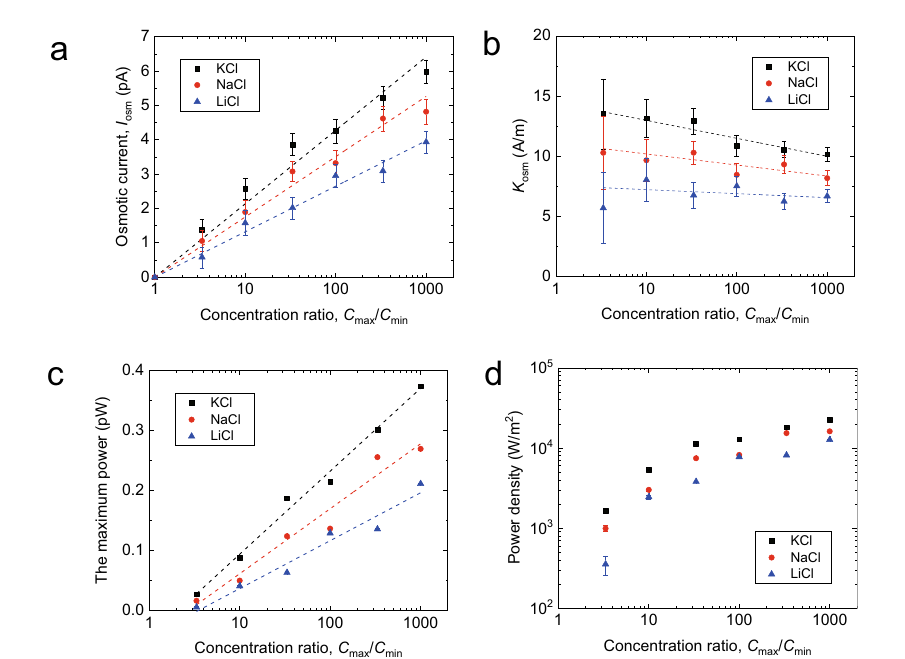
Fig.3|Osmoticpowergenerationundersalinitygradients.a Osmoticstreaming current versus concentration ratio for single CNT nanochannel with KCl (black), NaCl (red), and LiCl (blue). Error bars are derived from the standard deviation of experimentallymeasured osmoticcurrents. b The transportcoef fi cient K osm ofthe